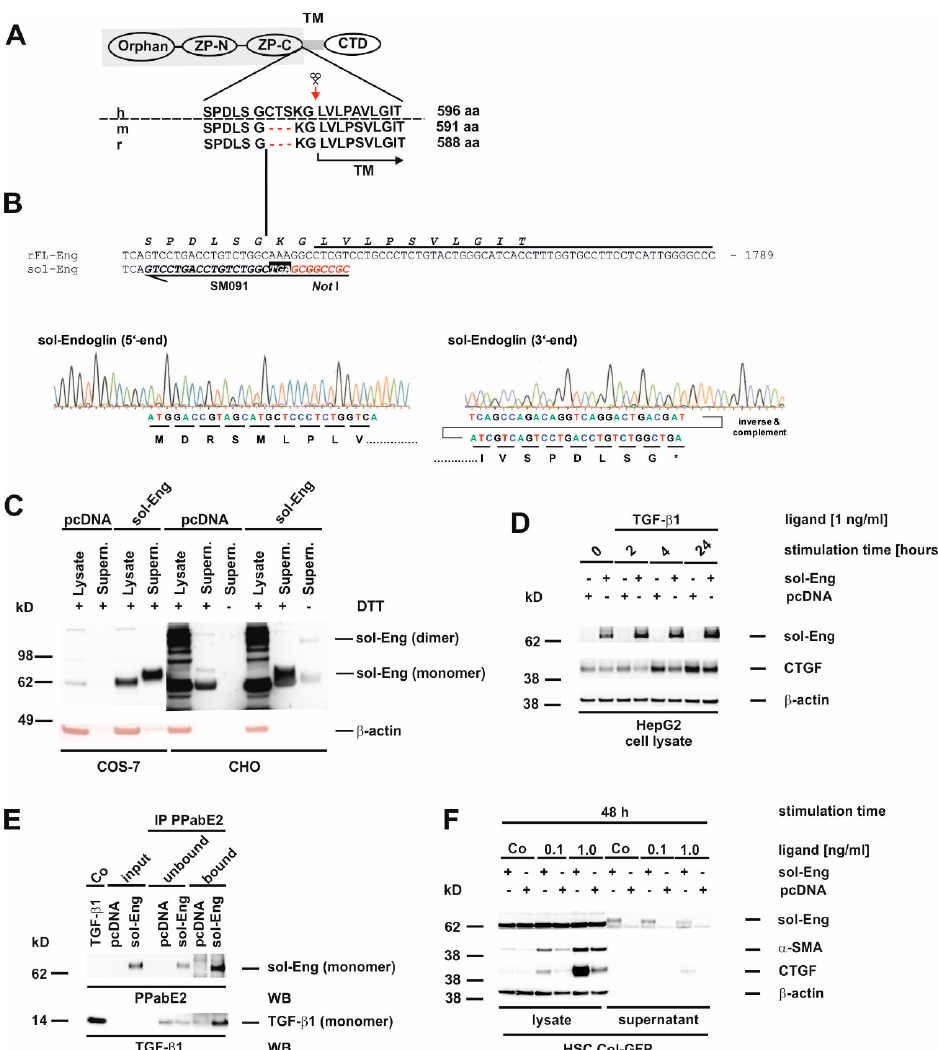
Figure 3. Structure, sequence analysis and functional expression of soluble Endoglin from rat. ( A ) Scheme of the FL-Endoglin (FL-Eng) domain structure including the amino acid environment surrounding the cleavage site (scissors and red arrow) of human, mouse and rat. ( B ) Nucleotide sequence of FL-Eng and the corresponding primer composition (SM091) to amplify sol-Eng and introduce a stop codon (TGA) and a Not I restriction site (upper panel). Sequence analysis of the sol-Eng expression plasmid (lower panel). For clarity the sequence data of the 3 ′ end was inversed and complemented for depicting the encoded amino acids. ( C ) COS-7 cells (left) and CHO cells (right) were transiently transfected with empty vector (pcDNA) or sol-Eng expression vector (sol-Eng). sol-Eng expression was displayed in Western blot in the presence (+) or absence ( − ) of DTT. ( D – E ) HepG2 cells were transiently transfected using empty vector (pcDNA) or sol-Eng expression vector (sol-Eng). Thereafter, cells were either treated or not with TGF- β 1 (1 ng/mL) for the indicated time points and sol-Eng expression and CTGF expression was monitored in Western blot ( D ) or the supernatant was supplemented with TGF- β 1. Binding was accomplished for 2 h rotating and sol-Eng complexes were precipitated overnight using a rat Eng-specific antibody (PPabE2) and analysed in Western blot for the presence of bound TGF- β 1 and precipitated sol-Eng. ( F ) HSC Col-GFP cells were transiently transfected using empty vector (pcDNA) or sol-Eng expression vector (sol-Eng). After starvation for 16 h, the cells were stimulated or not for 48 h with TGF- β 1 (0.1, 1.0 ng/mL). Cellular proteins were analysed in Western blot for transgene expression (sol-Eng), CTGF and α -SMA. Equal loading of proteins was proven by re-hybridization of the membranes with a β -actin